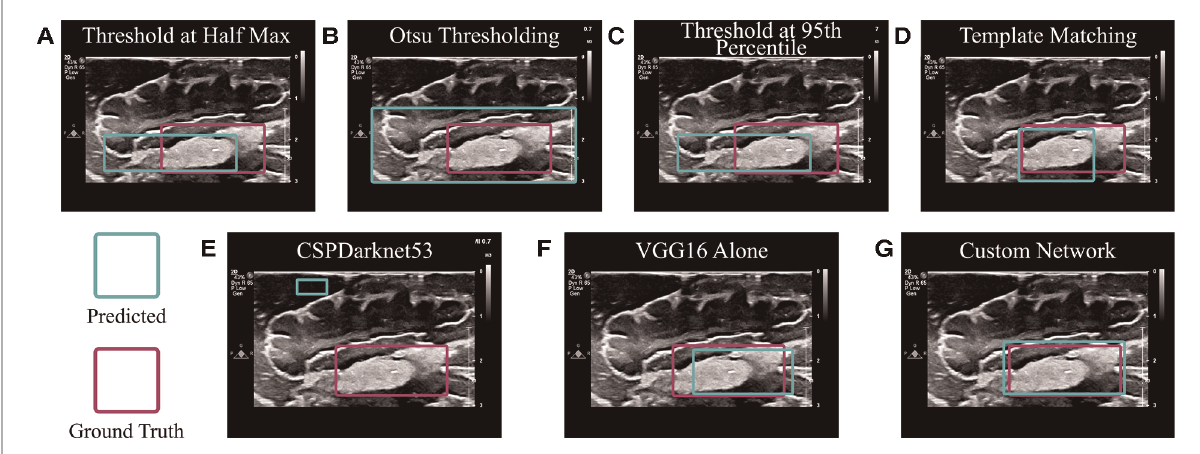
FIGURE 5 Algorithm comparison. ( A – D ) Non-deep learning algorithms were implemented to predict the location of a cotton ball in a neurosurgical ultrasound image. These included ( A ) Thresholding at half the maximum pixel intensity value; ( B ) Otsu thresholding; ( C ) Thresholding at the 95th percentile of the average pixel value within the ground truth bounding box of a training set; and ( D ) Matching the input image to a template image of a cotton ball. ( E ) CSPDarknet53 is the backbone of the YOLOv4 algorithm, which is known for object detection and classi fi cation. ( F ) VGG16 is often employed for object localization and was implemented as in (29). ( G ) A custom network was employed using a VGG16 backbone and additional dense network as described.